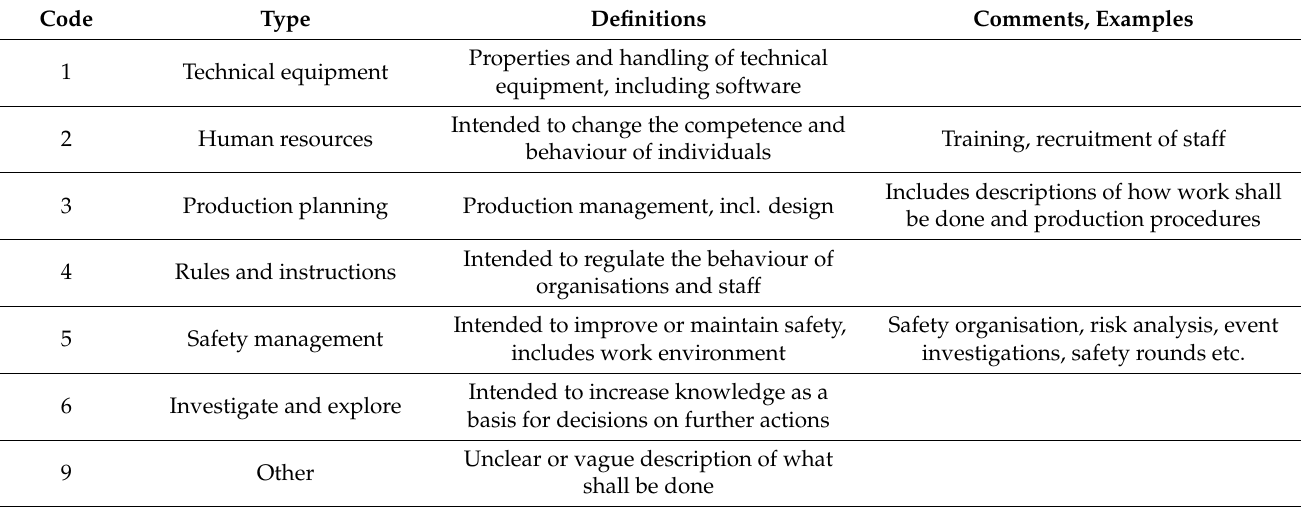
Table 2. Types of suggested reforms in event